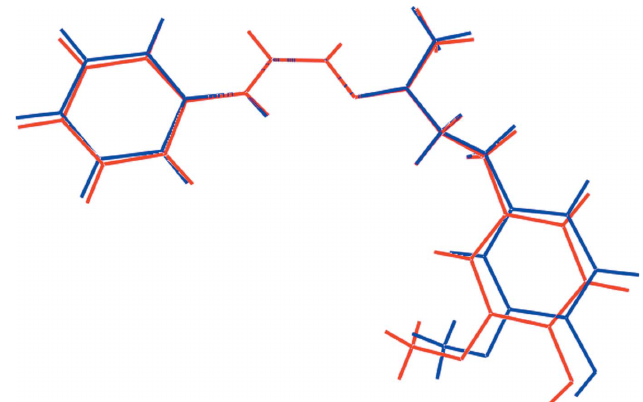
Figure 2 Overlay diagram for (I), with the O1-molecule (red image) and O4- molecule (blue image) superimposed so that the urea residues are coincident.